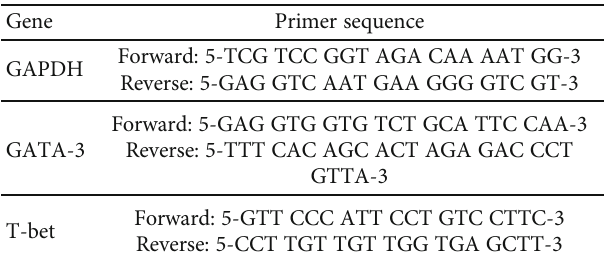
Table 2: Design of experiment A in Section 2.12. Groups